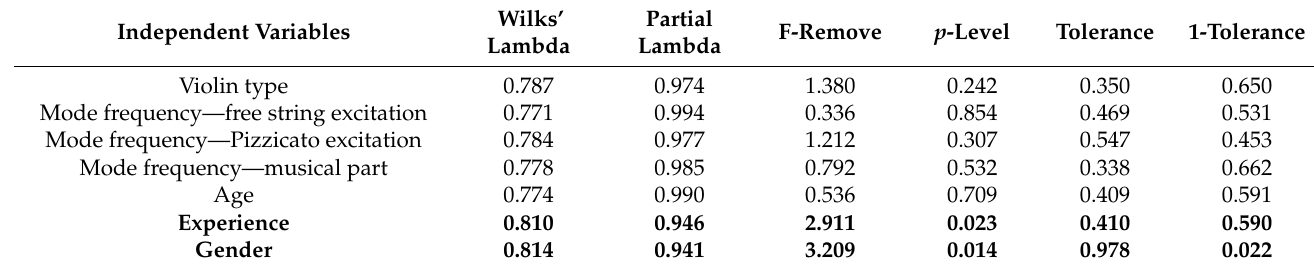
Table 3. The results of the multifactor discriminant analysis regarding sound clarity.